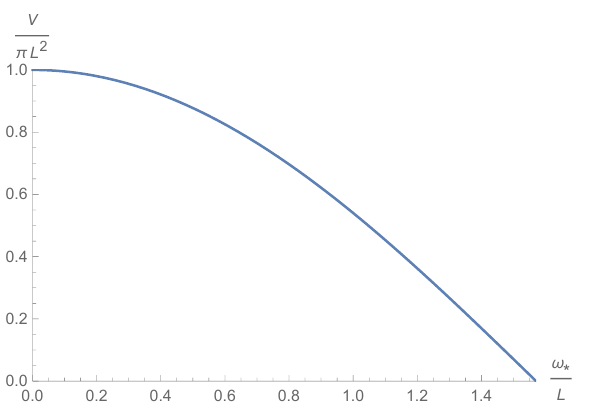
Figure 5 . The volume in CV proposal, for subsystem A half as large as the central slice, versus the minimal bulk radial coordinates of RT